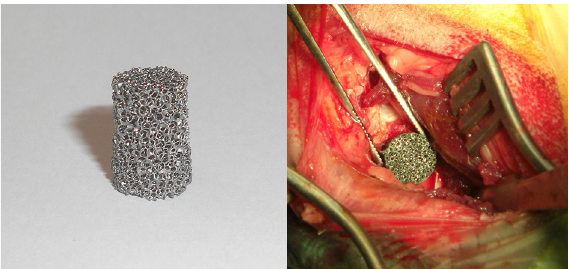
Figure 1. Degradable iron alloy implant and operative site of implant